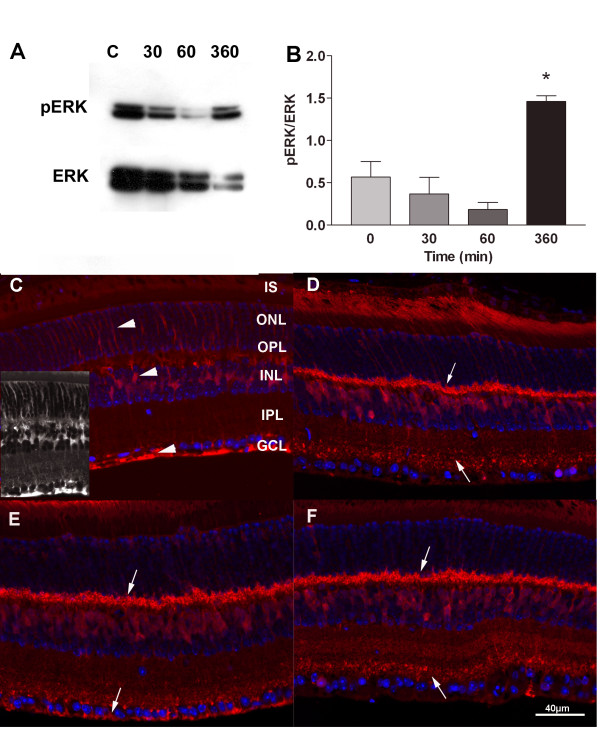
Activation of ERK-1 (MAPK1). A. Western blots were probed with anti-ERK-1 (pThr202/pTyr204) antibody. There was constitutive activation prior to optic nerve crush. However, the phosphorylation ratio (pERK/ERK) increased further at 360 min although the total ERK extracted was lower. B. Graph of the data in A normalized to the total ERK-1 protein. C-F Immunohistochemistry of activated ERK-1, at 0, 30 min, 60 min, and 360 min (6 hr) after optic nerve crush, respectively. Increased labeling of cells in the OPL (down arrows) are particularly evident at 30 min as well as decreased labeling of Muller cells that extend the from the ONL to the GCL (arrowheads). Also note that there is immunolabeling for pERK-1 in the inner stratum of the inner plexiform layer at 30 min and 6 hrs (up arrows) and labeling in the ganglion cell layer at 60 min (arrowheads). The grayscale inset in C shows the staining of the Muller cell marker glutamine synthase. Red = pERK-1, Blue = DAPI.